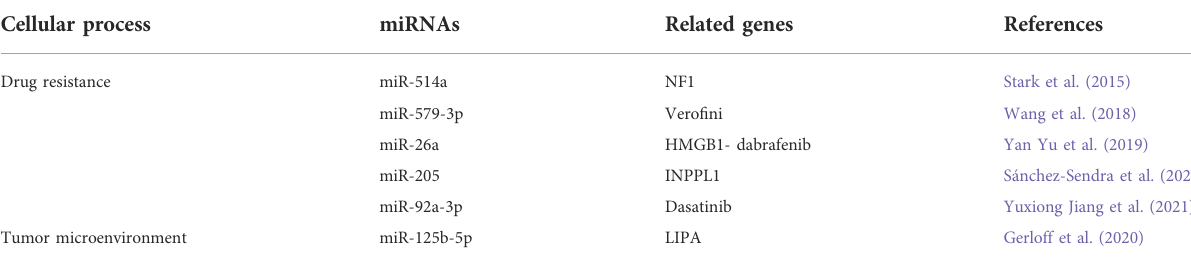
TABLE 6 Functional characterization of miRNAs in drug resistance and the tumor microenvironment of melanoma. Cellular